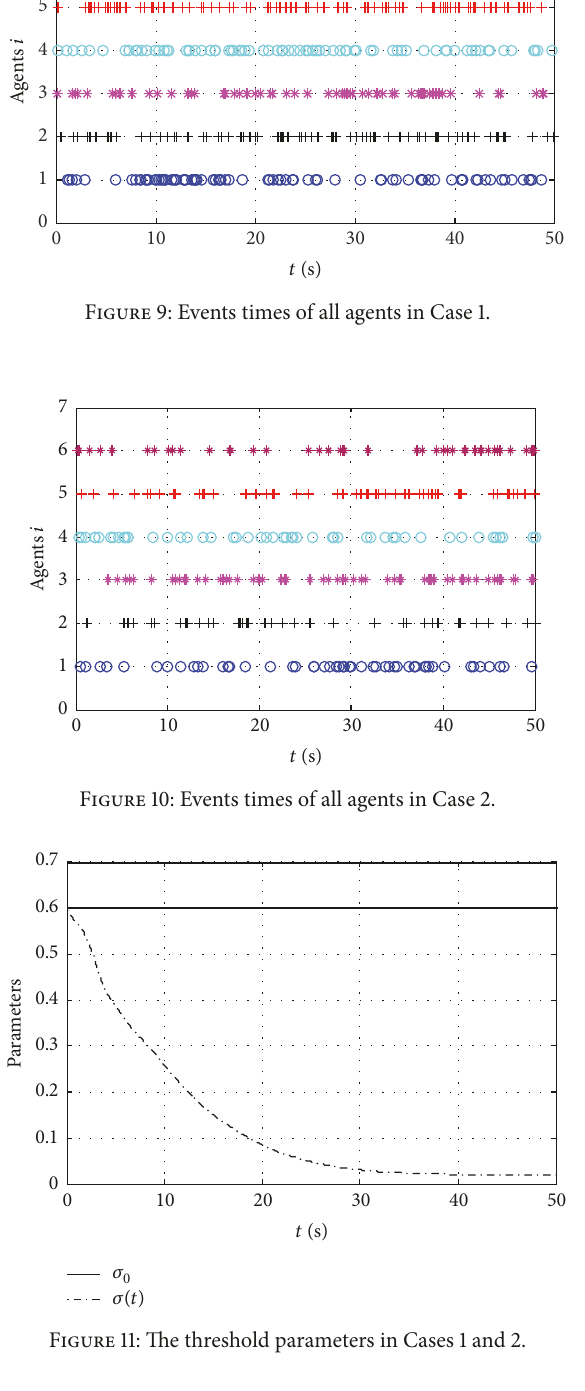
(5) Based on most of the computed performance indexes in Table 4, the controller in Case 1 can achieve better formation performance than that in Case 2. Although less events are derived by using a fixed threshold parameter, the formation performance is